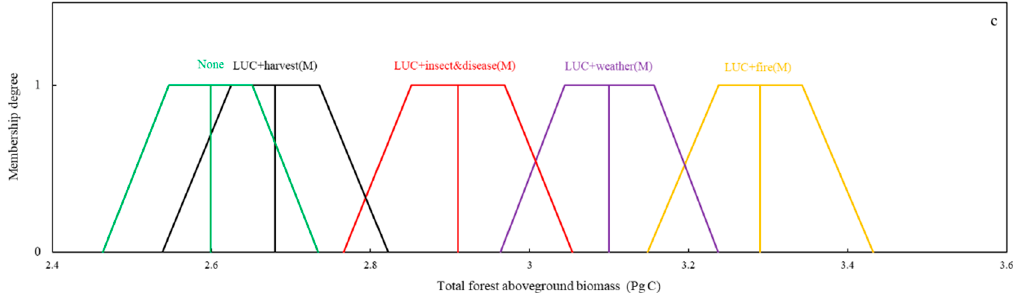
Figure 8. Fuzzy sets representing uncertainty in the total forest aboveground biomass (Pg C) from 2018 to 2098 with land use change (LUC) ( a ), disturbances ( b ), and LUC + disturbances ( c ) in the Northern US. Land use change (forest [F] → agriculture and settlements/other [A&S], and A&S → F) included specific changes from F → A, F → S, F → A&S, A → F, S → F, and A&S → F. Disturbance included fire, weather, insect and disease, and harvest. All LUC and disturbance scenarios use medium intensity/severity. None represents forests that naturally grow without considering LUC and disturbances.